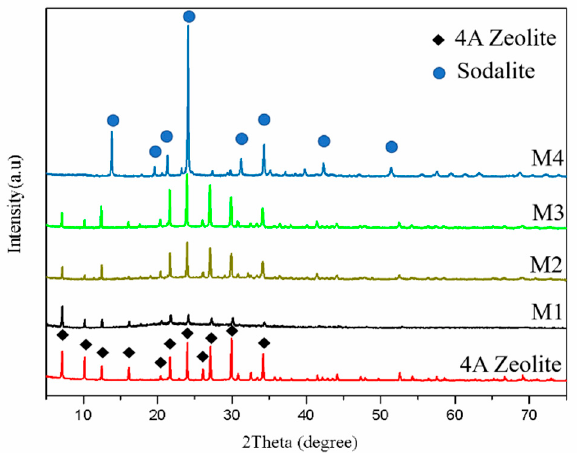
Figure 3. X-ray diffraction (XRD) spectra of 4A zeolite and various materials with different Na 2 CO 3 contents.